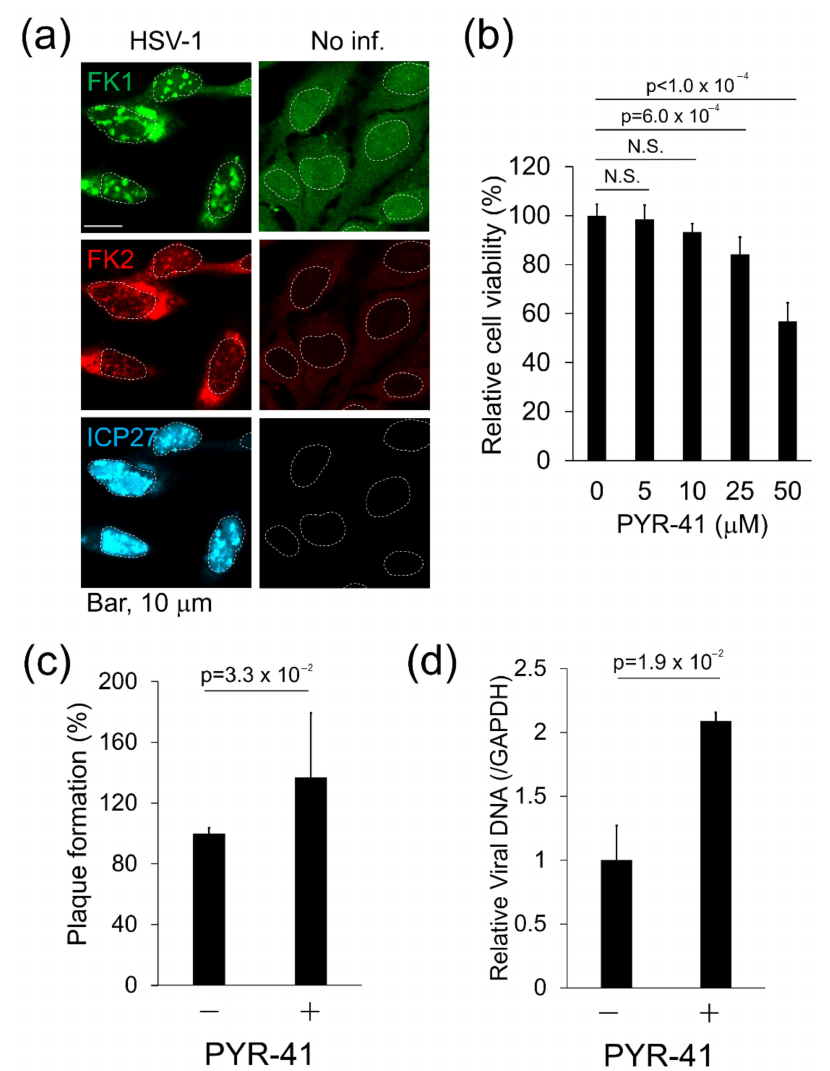
Figure 1. The UBE1 inhibitor PYR-41 increased herpes simplex virus-1 (HSV-1) replication. ( a ) Subcellular localization of Ub-conjugates and UBE1a in HSV-1-infected cells. HeLa cells were infected with HSV-1 at a multiplicity of infection (MOI) of 2 for 60 min. At 18 h post-infection (hpi), cells were fixed and stained with FK1 (green), FK2 (red), and anti-ICP27 (cyan) antibodies. Right and left images show HSV-1 infected and mock-infected cells, respectively. The immediate early (IE) gene product, ICP27, was used as a positive control for HSV infection. The white dotted lines indicate the outline of nuclei. ( b ) Cell viability of PYR-41-treated Vero cells. Vero cells were treated with 0–50 µ M PYR-41 and cultured for 48 h. The number of viable cells was evaluated by a cell viability assay. The values obtained from PYR-41-untreated cells were set as 100%. N.S., not significant. ( c ) PYR-41-treatment increased virus production. Vero cells were infected with HSV-1 at 50 plaque-forming units (pfu) / well for 30 min and cultured in media with or without 30 µ M PYR-41 for 48 h. The values obtained from PYR-41-untreated cells were set at 100%. Error bars indicate standard deviations from three independent experiments. ( d ) PYR-41 increased viral DNA replication. Vero cells were infected with HSV-1 at an MOI of 0.01 for 30 min and cultured with 25 µ M PYR-41 for 24 h. The HSV-1 genome from harvested cells was quantified by real-time PCR and normalized by using total DNA. Values obtained from untreated cells were set as 1.0. Error bars indicate standard deviations from three independent